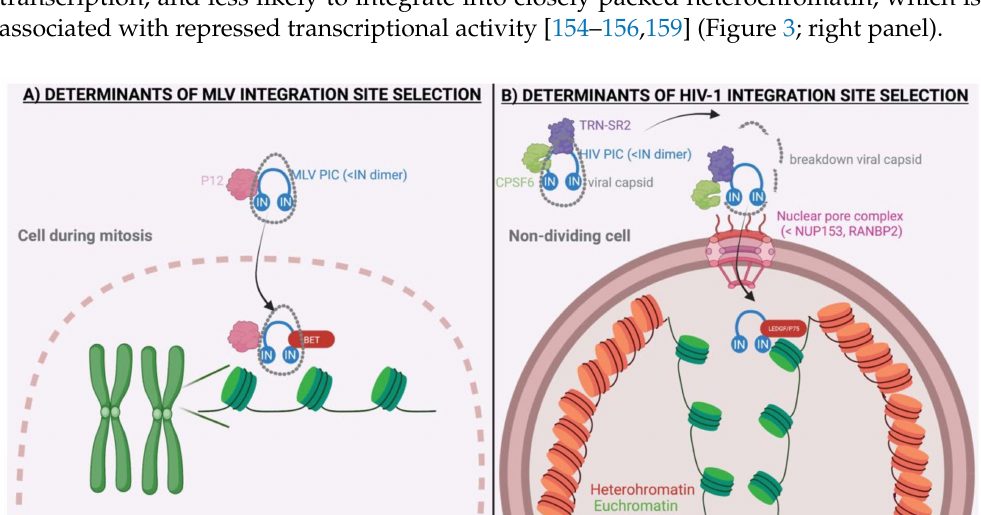
nucleosomes. ( B ) Determinants of human immunodeficiency virus 1 (HIV-1). HIV-1 tends to